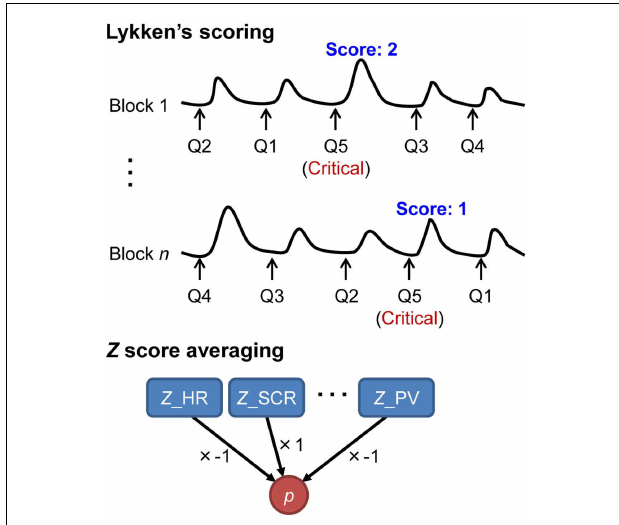
FIGURE 1 | Illustrations of the standard statistical methods: Lykken’s scoring and z- score averaging. Z _HR, a z -score for heart rate; Z _SCR, a z -score for skin conductance response; Z _PV, a z -score for pulse volume; p , probability. Lykken’s scoring assigns a score of 2 if the critical item elicited the largest response, a score of 1 if the critical item elicited the second largest response, and a score of 0 otherwise in each block. In z- score averaging, z- scores are simply averaged across blocks and measures. Z -scores may be multiplied by − 1 if a smaller response is characteristic of